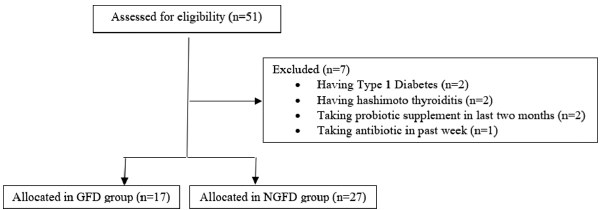
Figure 1. Flowchart of inclusion of participants in the current study. GFD, compliant to gluten-free diet group; NGFD, non-compliant to gluten-free diet